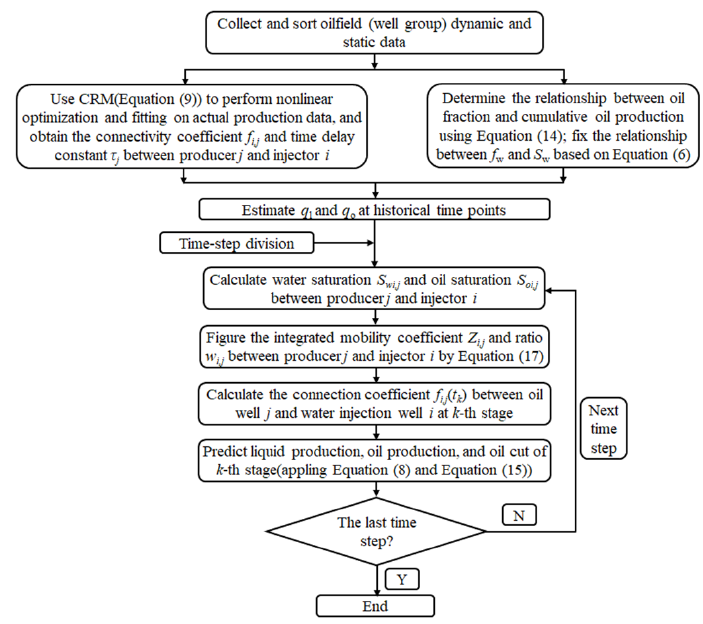
Figure 3. The flow chart of the calculation procedure. (1) Dynamic and static data collection including oil–water viscosity and oil–water phase permeability curves, etc. Based on the phase permeability curves, the relationship between relative permeability of the oil–water phase and water saturation, and the parame- ters m and n of the relationship between water cut and water saturation can be obtained by using the following equation [3]: